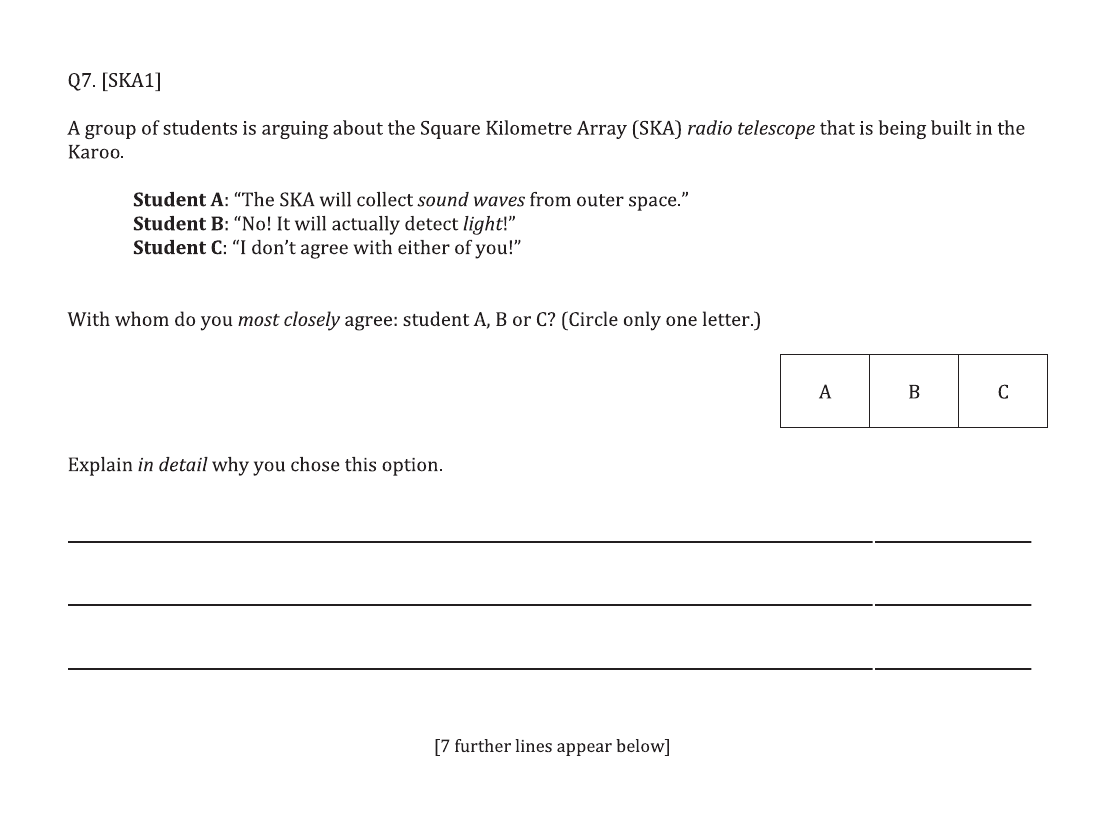
FIG. 1. Sample question from the precourse questionnaire, illustrating the format used for most questions in the instrument. For brevity, a number of the lines provided for students ’ responses have been truncated. The full list of questions (sans original formatting) may be found in Appendix